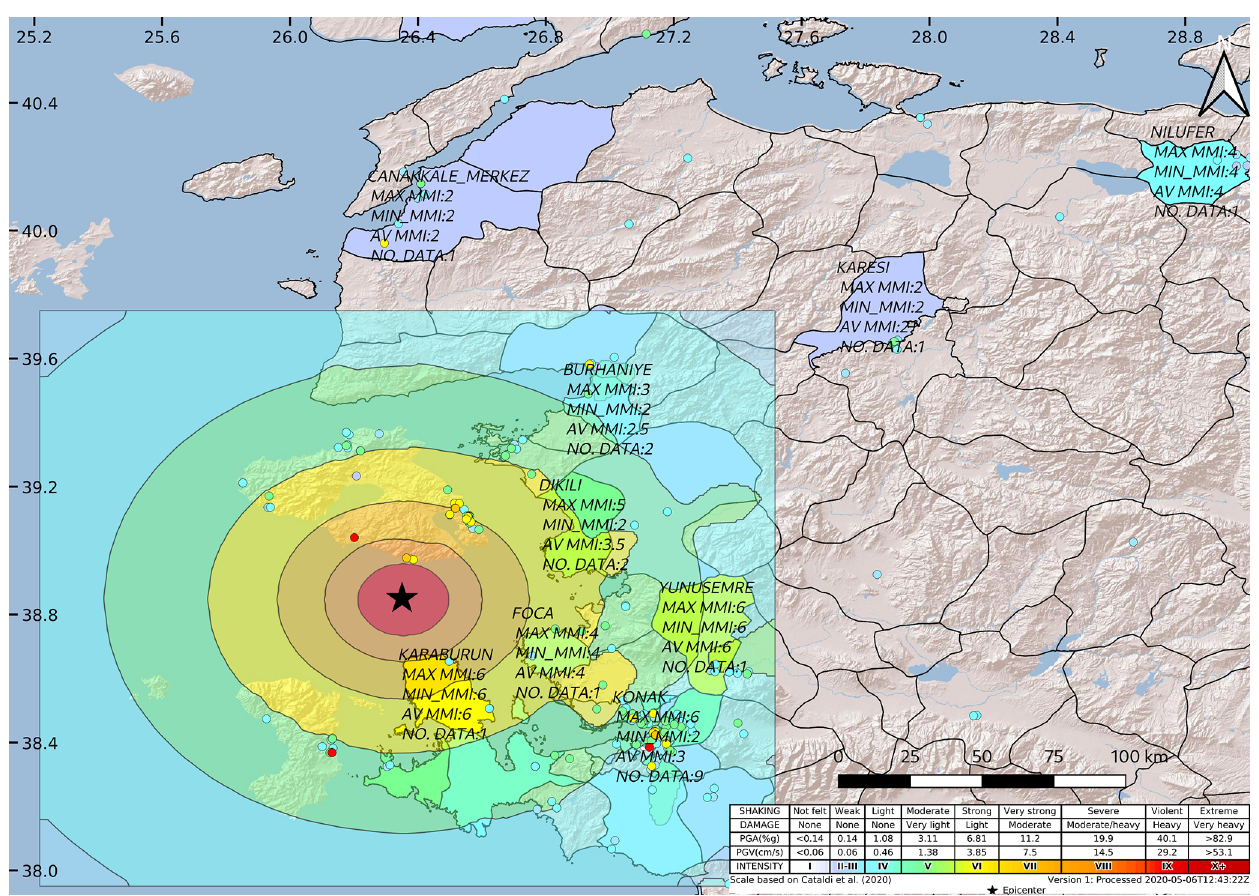
Figure 1. Intensity map of the 12 June 2017 Lesbos earthquake with labeled entries. Entries are plotted to district level polygons since the exact locations of the data providers are unknown. Felt reports of the earthquake submitted to EMSC are given at the top of the labeled entries (created using